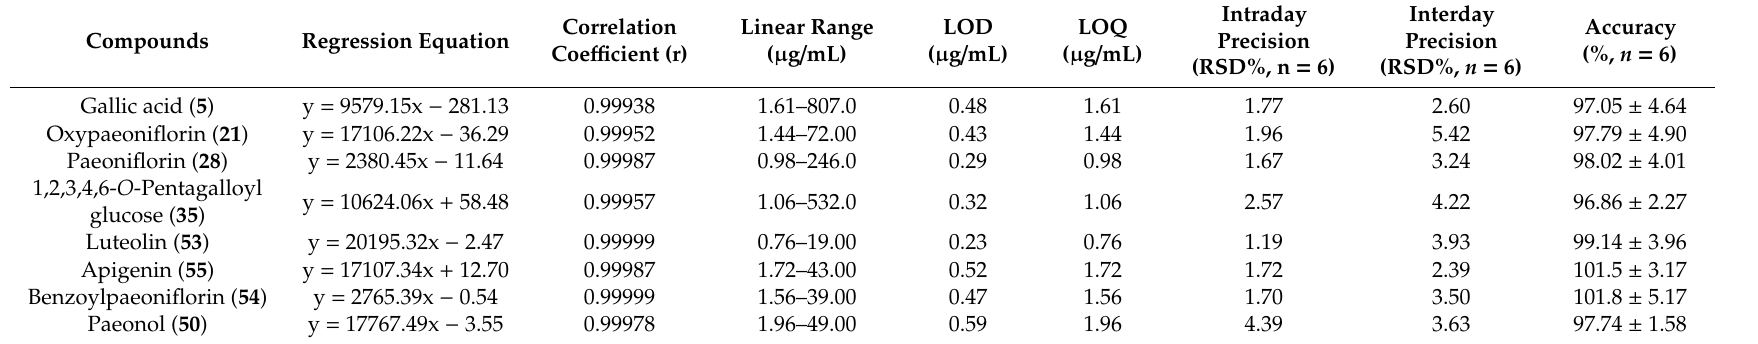
Table 3. Method validation of three phenols, three monoterpenoids, and two flavonoids.